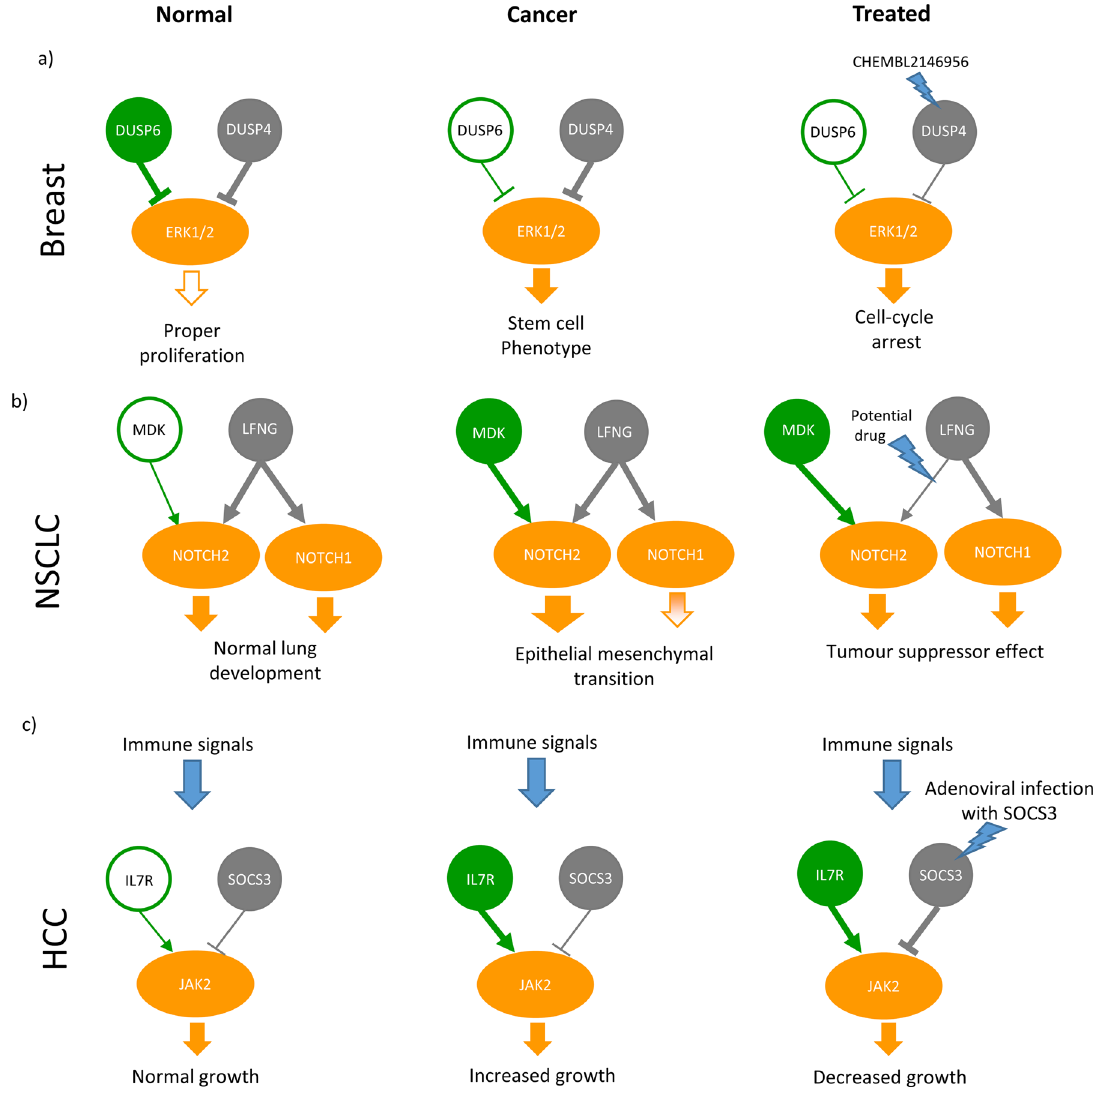
Fig. 4 In fl uencer proteins in breast cancer, NSCLC and HCC. a – c Effect of three further in fl uencer proteins, DUSP4, LFNG and SOCS3 in breast cancer, non-small cell lung and in hepatocellular carcinoma, respectively. As in Fig. 3, we compared the probable effect of the in fl uencer proteins on cancer-related proteins in normal, cancer and treated cases. DUSP4 effects ERK signalling ( a ), LFNG stimulates the Notch pathway ( b ), while SOCS3 is an inhibitor of the JAK/STAT pathway ( c ). Note the colour codes for the proteins: Green node: cancer-related, expressed protein; green empty node: Cancer-related, not expressed protein; orange node: fi rst neighbour protein; grey node: unaffected protein, in fl uencer; arrow : stimulation; blunted arrow :